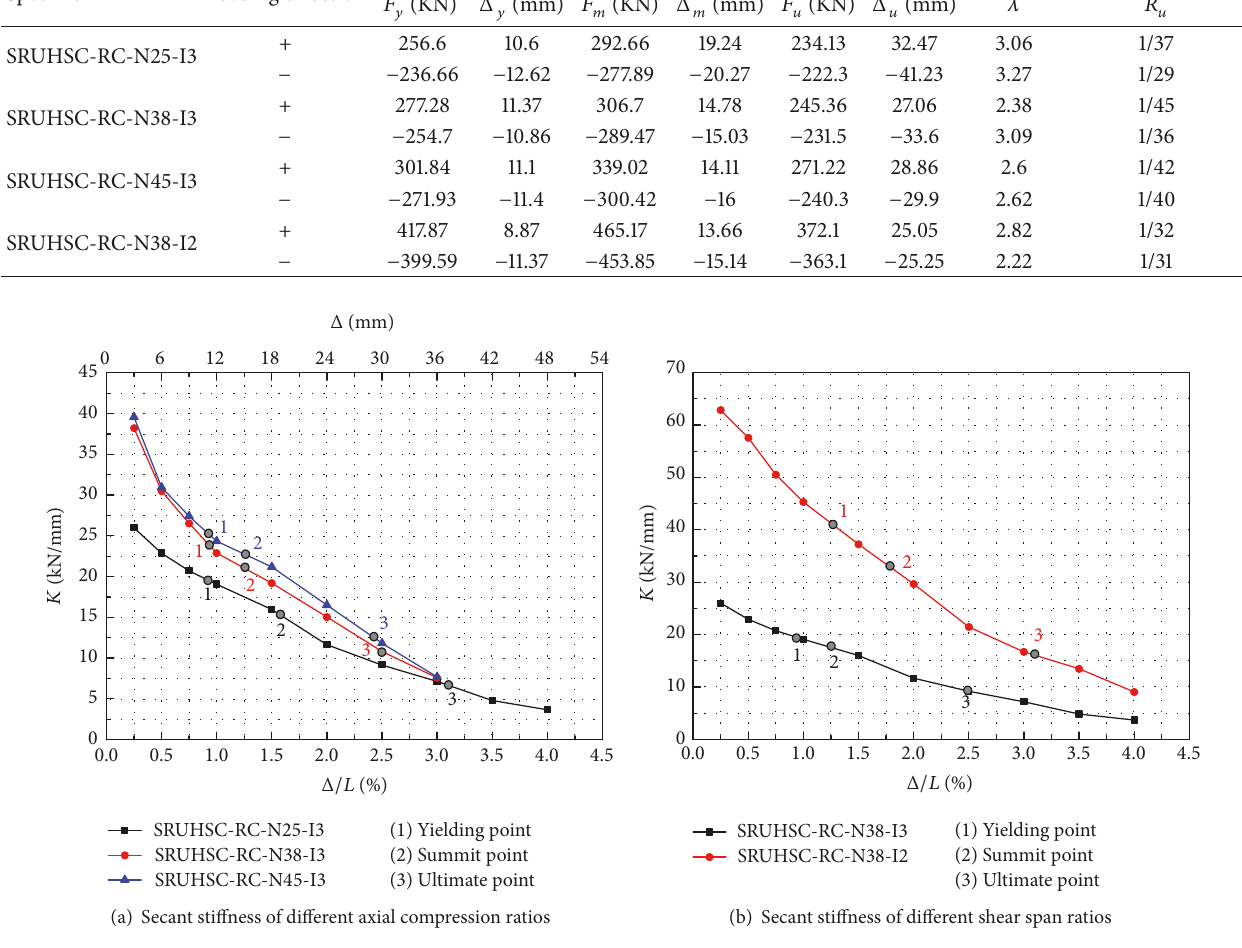
(b) Secant stiffness of different shear span ratios Figure 9: Secant stiffness degradation of the